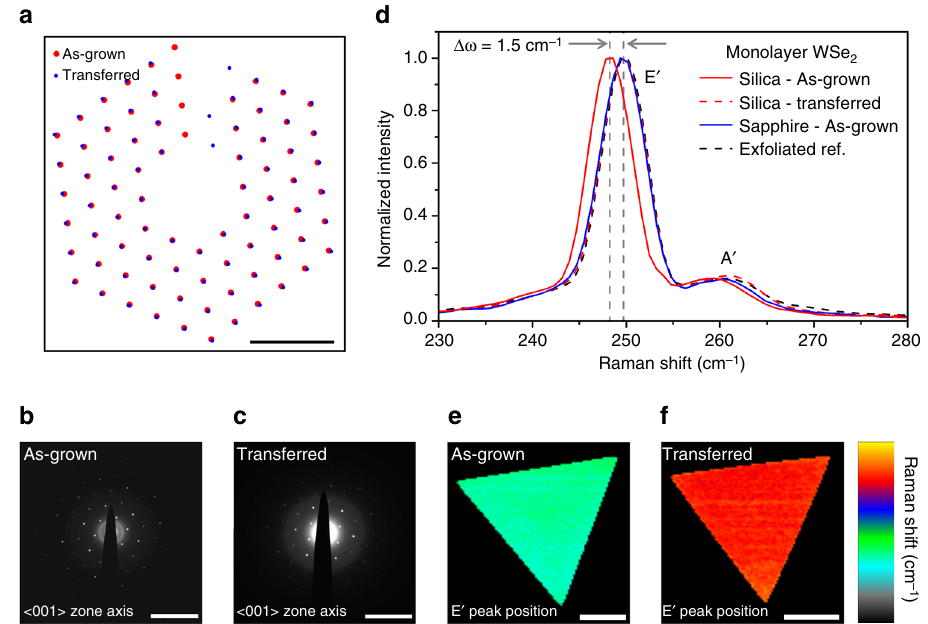
Fig. 2 Transmission electron microscopy images and Raman spectroscopy of monolayer WSe 2 . a Overlay of diffraction spots for as-grown and transferred monolayer WSe 2 , showing a 1.39 ± 0.28% strain in samples grown directly on the TEM membrane. Scale bar is 10 nm − 1 . b Electron diffraction patterns of a tensile strained WSe 2 monolayer grown directly on an 8 nm SiO 2 TEM membrane and c a WSe 2 monolayer transferred to the same thickness membrane. Scale bar is 10 nm − 1 . d Raman spectra of WSe 2 monolayers grown on various substrates. e , f Raman mapping of E ’ peak position for a ( e ) tensile strained WSe 2 monolayer as-grown on fused silica and a ( f ) WSe 2 monolayer transferred to release strain; data are plotted using the same false color scheme. Scale bar is 20 μ m, data range is 250.5 to 247.0 cm